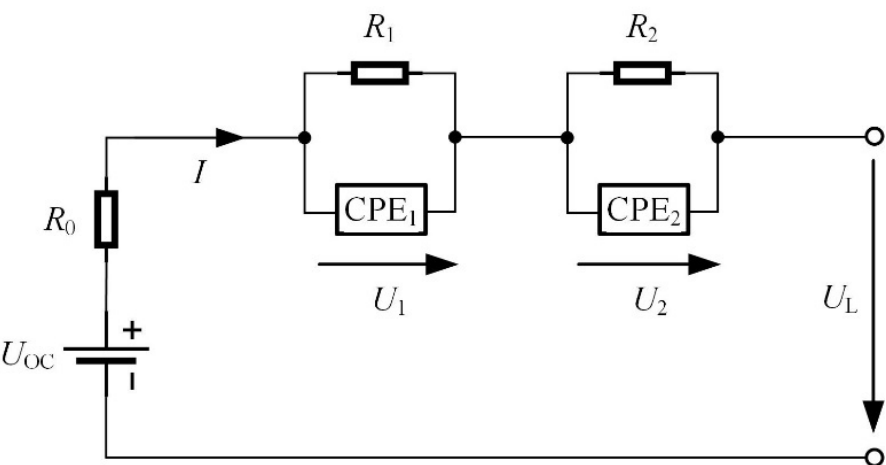
Figure 1. The FOM of a lithium battery.